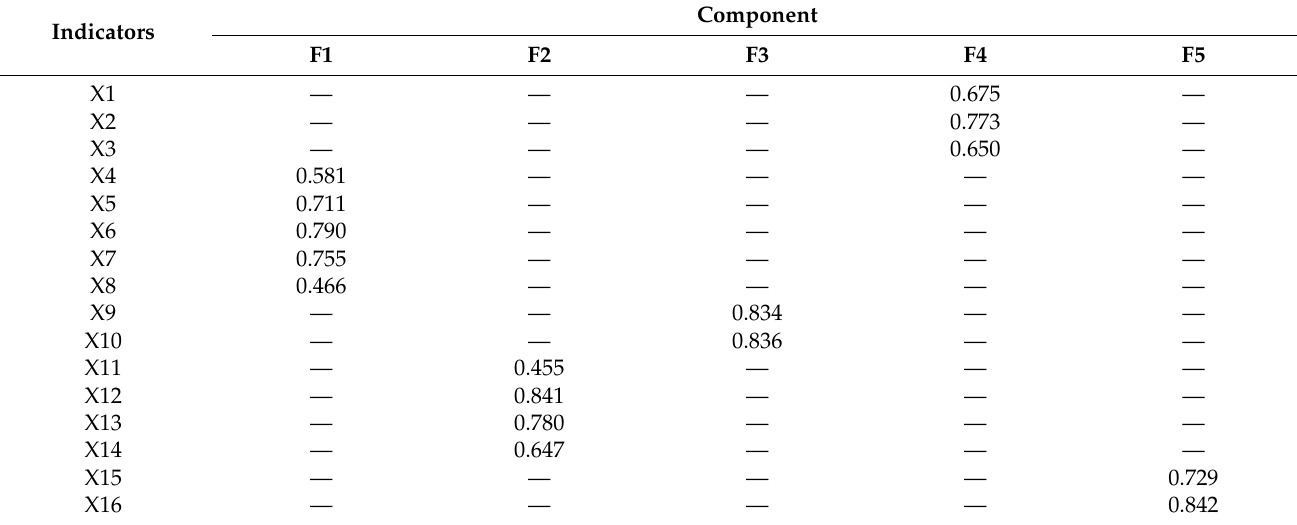
Table A3. Rotated component loading matrix.